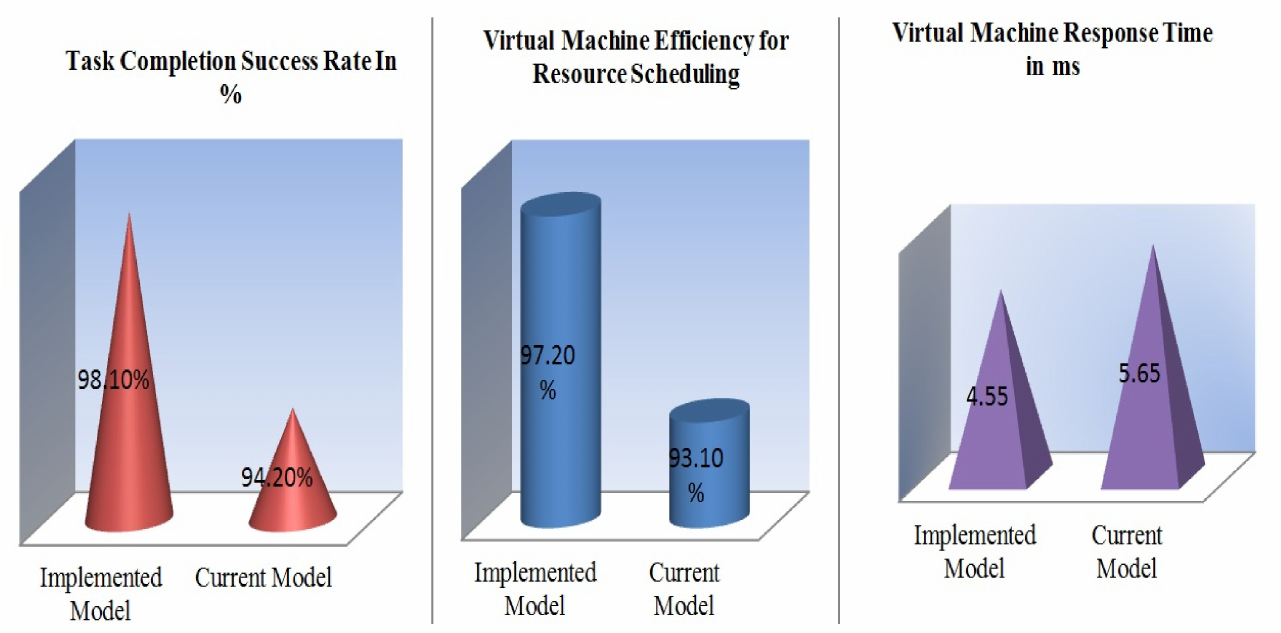
Figure 12. Comparison of